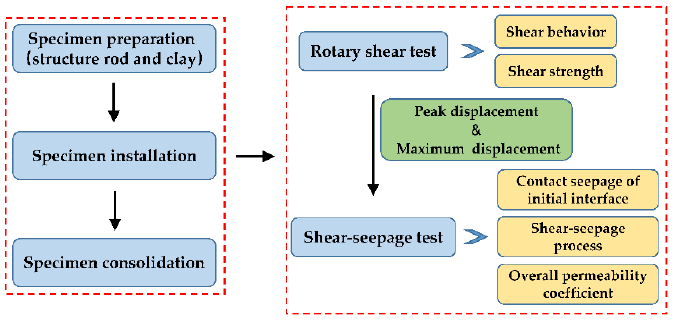
Figure 6. The experimental flowchart in this study.